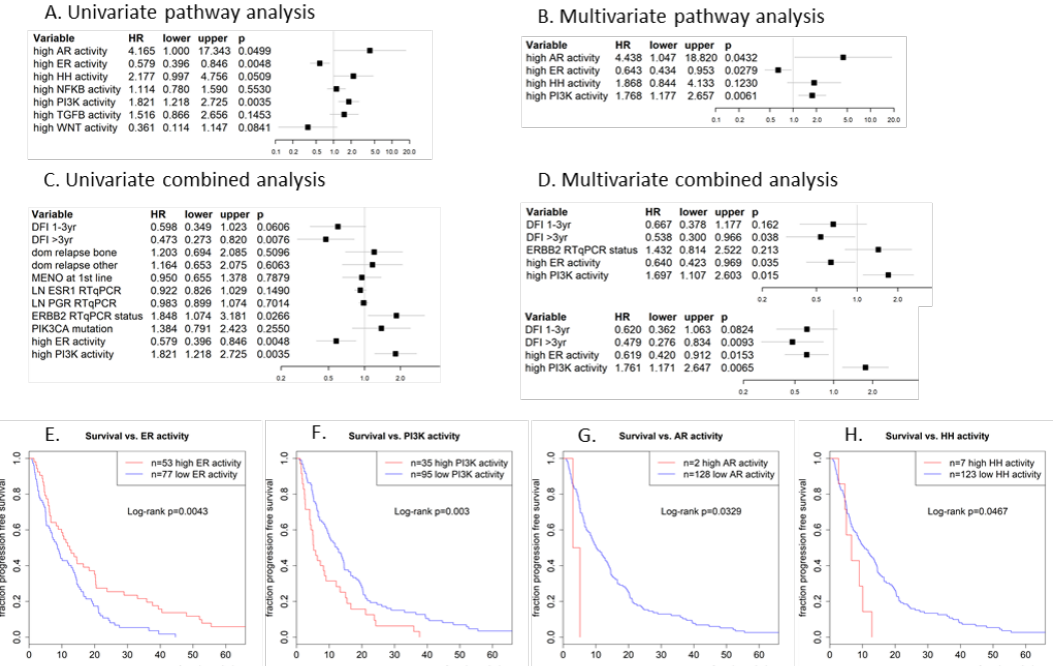
Figure 4. Cox proportional hazards regression analysis of progression-free survival vs. ( A , B ) dichotomized pathway activities (log2odds > 0) and vs. ( C , D ) dichotomized pathway activities combined with traditional predictors. ( A ) univariate analysis with all 7 pathways, ( B ) multivariate analysis of pathway activities that were significant in the univariate analysis, ( C ) univariate analysis of most significant pathways from ( B ) with clinical predictors, ( D ) multivariate analysis with the significant predictors from univariate analysis ( D ). Used clinical predictors are: disease-free interval (1 – 3yr or >3yr vs. reference DFI < 1yr), dominant site of relapse (bone or other vs. reference local), menopausal status at start 1st line therapy, log ESR1 and PGR RT-qPCR expression (as continuous predictor), HER2/ ERBB2 RT-qPCR status (amplified vs. reference not amplified) and PIK3CA mutation status (mutated vs. reference wildype). ( E ) Kaplan-Meijer plot for progression-free survival of patients with a high ER pathway activity (log2odds > 0; red line) vs. patients with a low ER pathway activity (log2odds ≤ 0; blue line). ( F ) Similarly, for the PI3K pathway, ( G ) AR pathway, and ( H ) HH pathway. The PI3K pathway is considered to be active in case of low FOXO activity or in case of combined